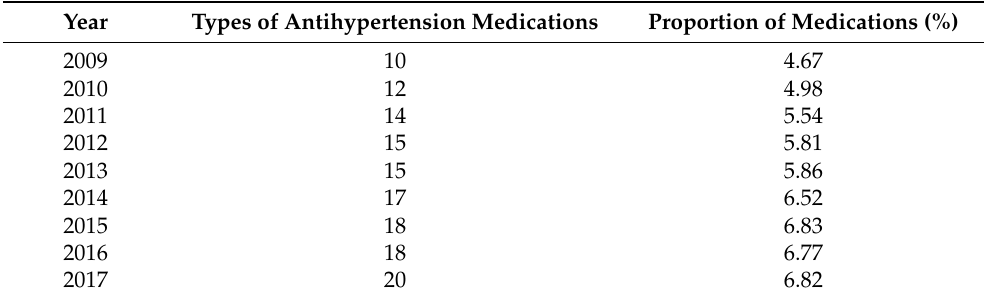
Table 2. The number of types and proportion of antihypertensive medications provided by the basic public health service project in Inner Mongolia, 2009–2017.